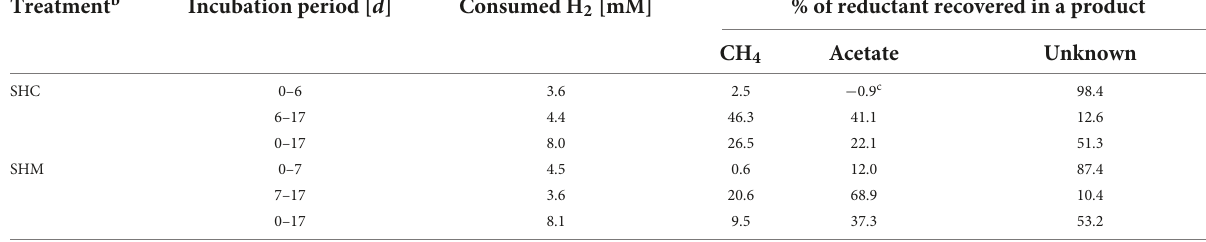
TABLE 1 Reductant recoveries for supplemental H 2 consumed in soil H 2 treatments a